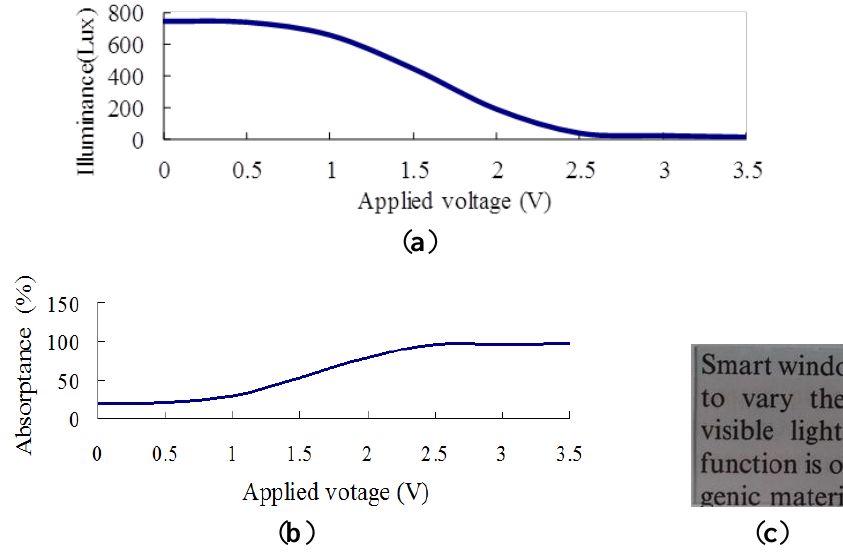
Figure 9. Transmittance and absorptance properties of ITO/WO electrolyte/ITO stack given electrolyte thickness of 750 nm and incident illuminance of 900 Lux. ( a ) Transmittance given applied voltage of 0–3.5 V; ( b ) absorptance given applied voltage of 0–3.5 V; and ( c ) transparency of EC stack given no applied voltage.